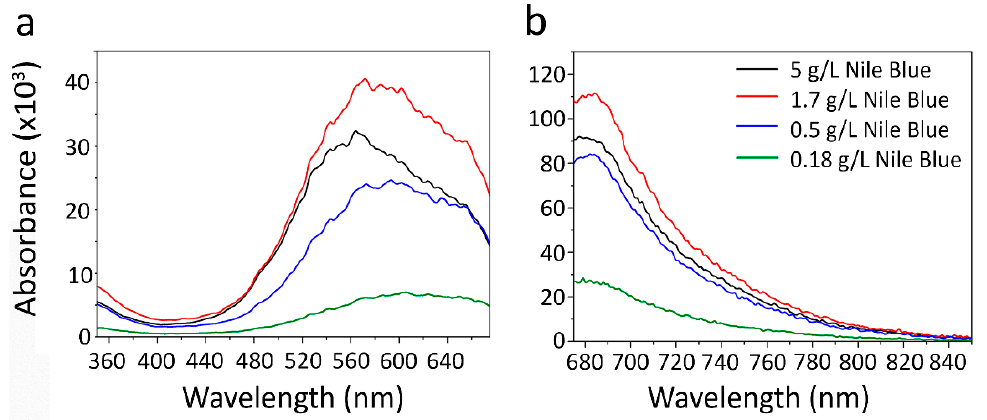
Figure 5. Fluorescence analysis of nanoparticles. ( a ) The excitation spectra (emission wavelength 700 nm) of PLGA nanoparticles according to the fluorescent dye concentration. ( b ) The emission spectra (excitation wavelength 650 nm) of PLGA nanoparticles according to fluorescent dye concen- tration.